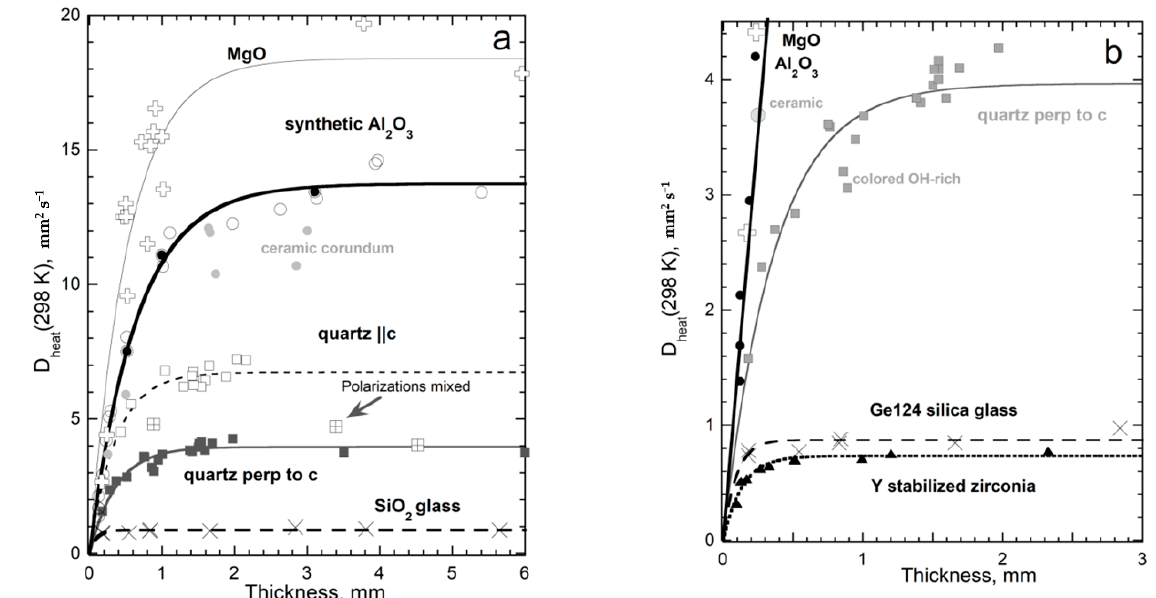
Figure 7. Dependence of D heat at 298 K on thickness. Fits are least squares to (22): ( a ) High D samples. Not shown is a point for MgO at 17.5 mm 2 s − 1 for L = 10.0 mm. Open plus = MgO. Circles = corundum, with black dots representing (1120) orientations. Grey dots = ceramic Al 2 O 3 . Squares = two orientations of quartz. X = Ge124 silica glass. ( b ) Expanded view showing low D and emphasizing thin samples. Triangles = yttrium stabilized cubic zirconia. These samples are fairly hard, permitting the preparation of sections approaching L = 0.1 mm at 5–6 mm across. Soft materials (alkali halides and micas), shown previously [4], are omitted due to difficulties in preparing very thin sections with parallel faces. Modified after Figure 7.9 in Hofmeister [4], with permission from Elsevier.